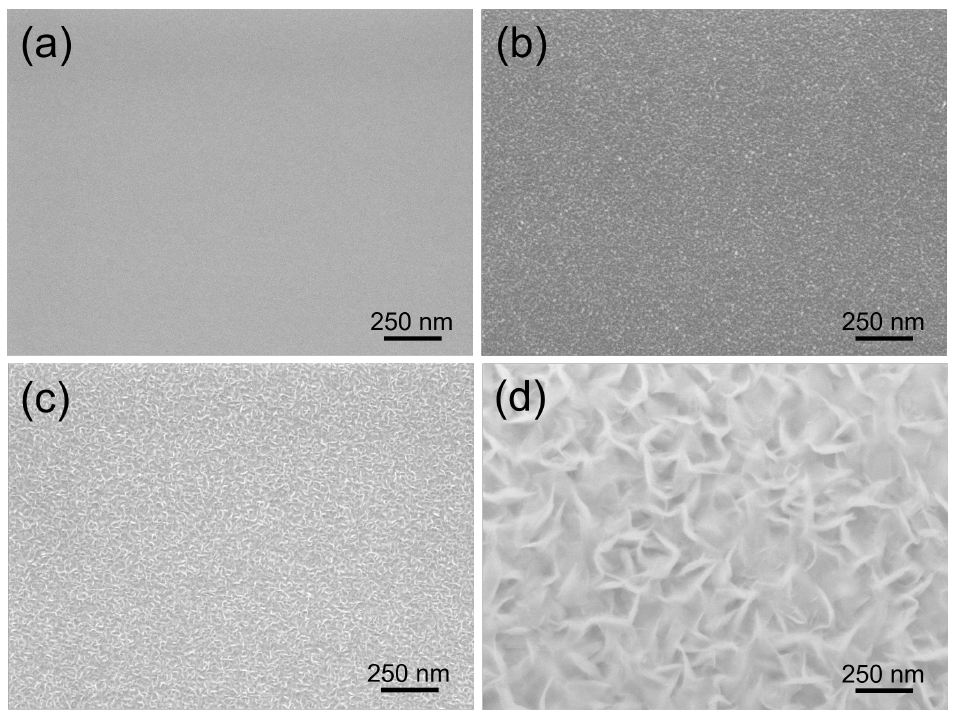
Figure 1. SEM images of BN films deposited on Si wafers under the same conditions, except for varying deposition times of ( a ): 10 min; ( b ) 30 min; ( c ) 60 min; and ( d ) 90 min.